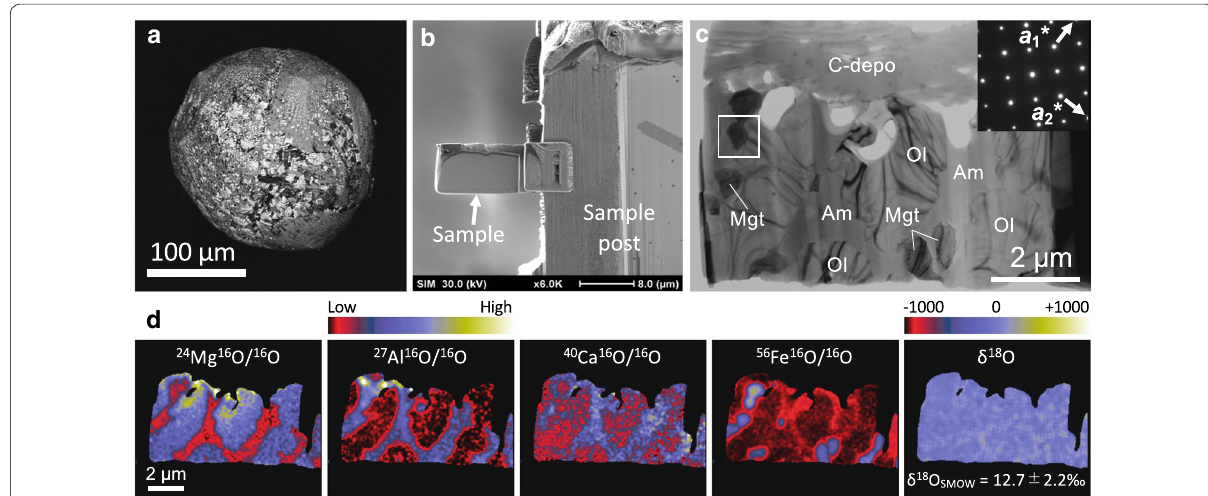
Fig. 5 A thin section of an Antarctic micrometeorite (AMM), a back-scattered electron image of the AMM, TT006b101, before focused-ion beam apparatus (FIB) processing, b the FIB-thin section attached to a post of the Kochi grid, c bright-field TEM image with a selected area electron diffraction pattern of Mg,Al-bearing magnetite as an inset, d NanoSIMS elemental ratio and O isotope